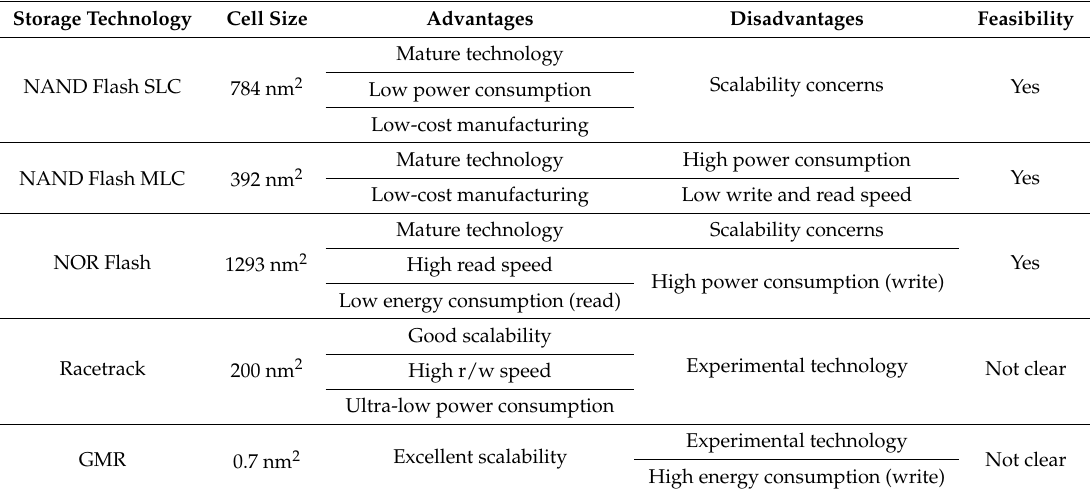
Table 2. Comparison of non-volatile memory technologies.